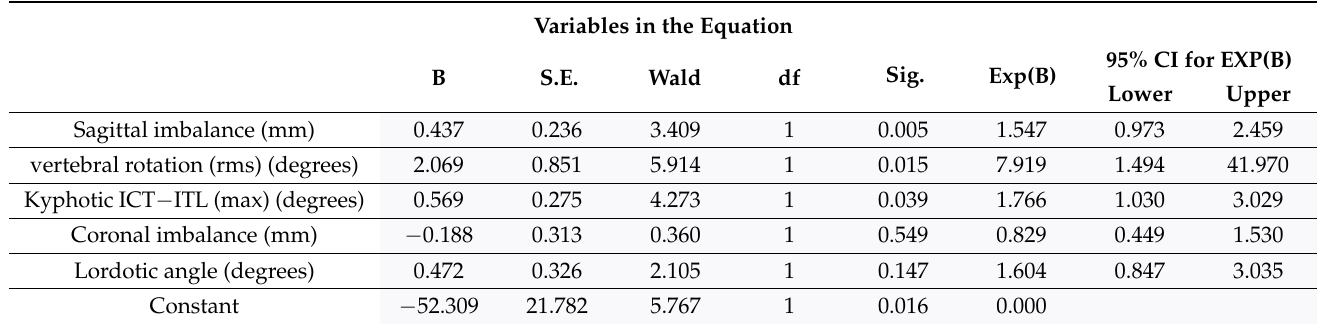
Table 3. Variables in the equation for logistic regression and odds ratio